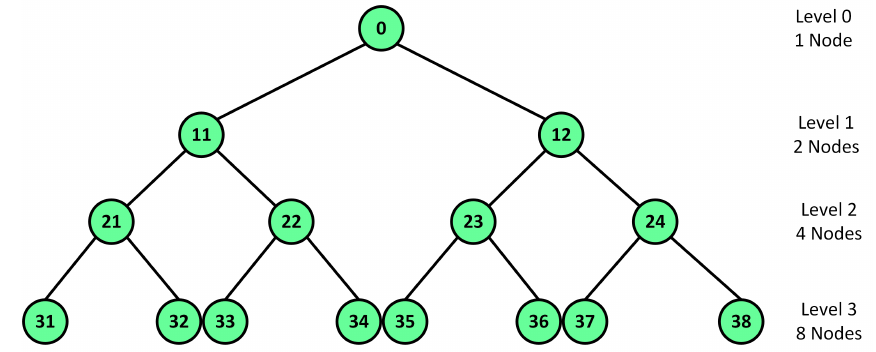
Figure 5. Binary level-3 wavelet packet tree